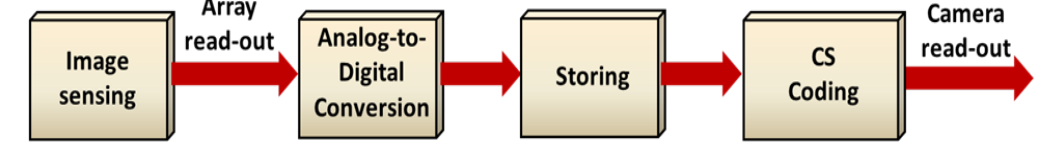
Figure 3. Block diagram for the digital implementation of CS coding.